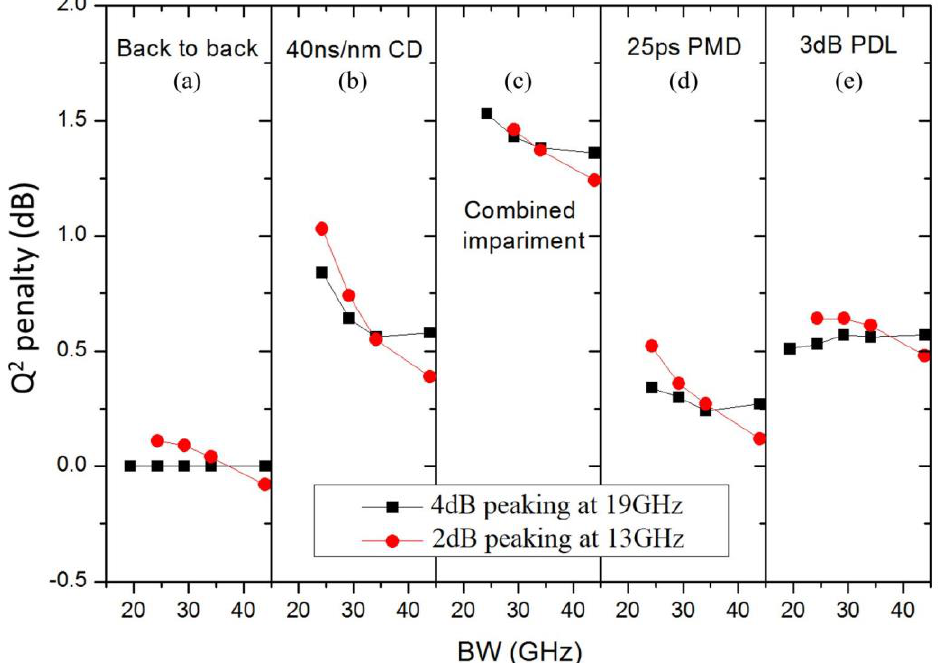
Figure 7. The penalty in Q 2 factor versus the receiver bandwidth under different scenarios of the transmission impairments. ( a ) Result in back-to-back setup. ( b ) Result with 40 ps/nm CD. ( c ) Result with combined impairment. ( d ) Result with 25 ps PMD. ( e ) Result with 3 dB PDL. The Combined impairments are 3-dB polarization dependent loss (PDL), 18-ps polarization mode dispersion (PMD), and 40-ns/nm chromatic dispersion (CD).